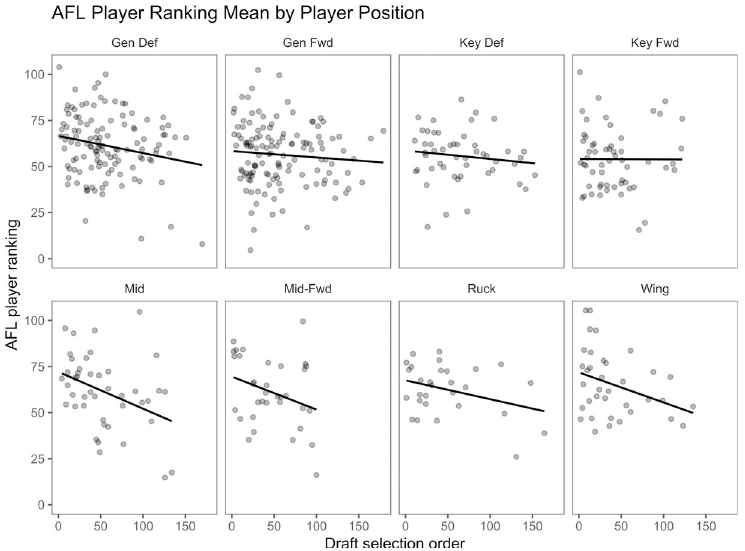
Fig 7. Relationship between draft selection order and AFL Player Ranking mean relative to playing